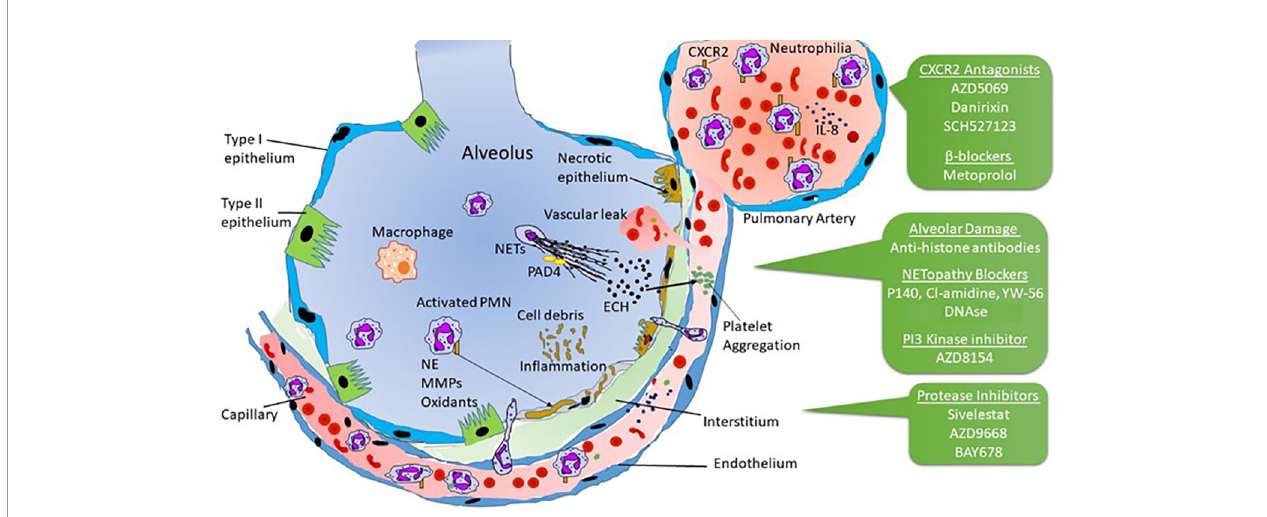
FIGURE 1 | Possible mechanisms of neutrophilia and NETopathy in alveolar-capillary damage affecting lungs in severe COVID-19. Pharmacological agents that may fi nd applications in progressive lung pathology are indicated in the green boxes and discussed in the